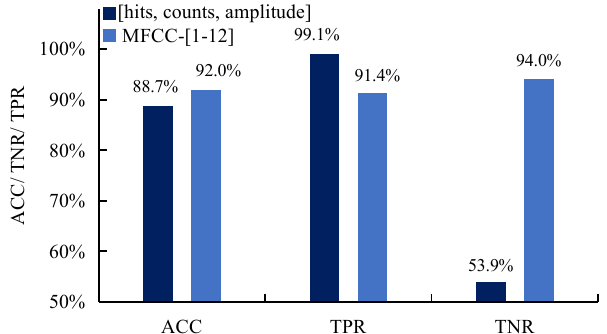
Figure 14. ACC, TPR, and TNR of AIEFPC on the AE sample set of ad8-5 and bd8-5, using cumulative hits, cumulative count, and amplitude as sample features and MFCC-6 as sample features.